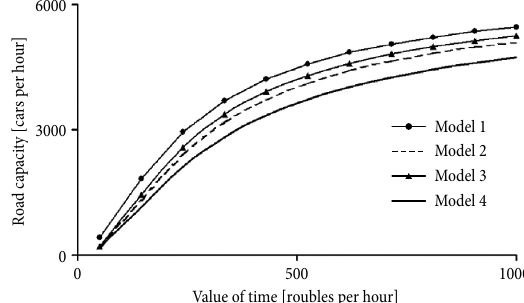
Fig. 8. Influence of car mode cost on public transport